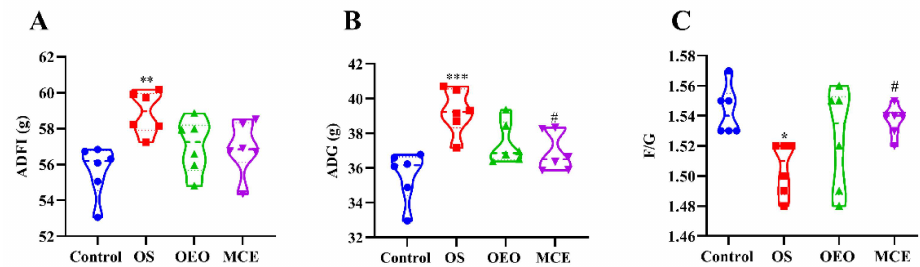
Figure 2. Growth performance of broilers. ( A ) Average daily feed intake (ADFI). ( B ) Average daily gain (ADG). ( C ) Average daily feed to gain ratio (F/G). * p < 0.05, ** p < 0.01, *** p < 0.001, vs. control group; # p < 0.05, vs. OS group ( n = 6).